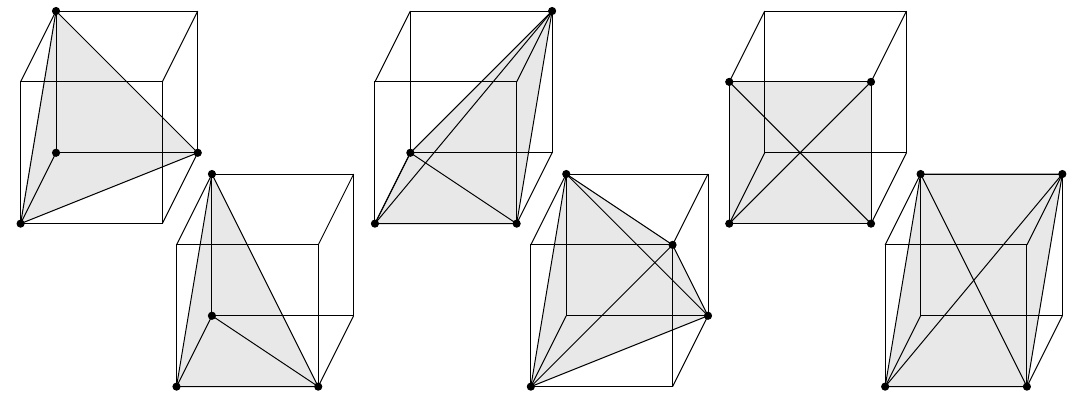
Figure 9: Representatives of each of the six 0/1 -equivalence classes of all 0/1